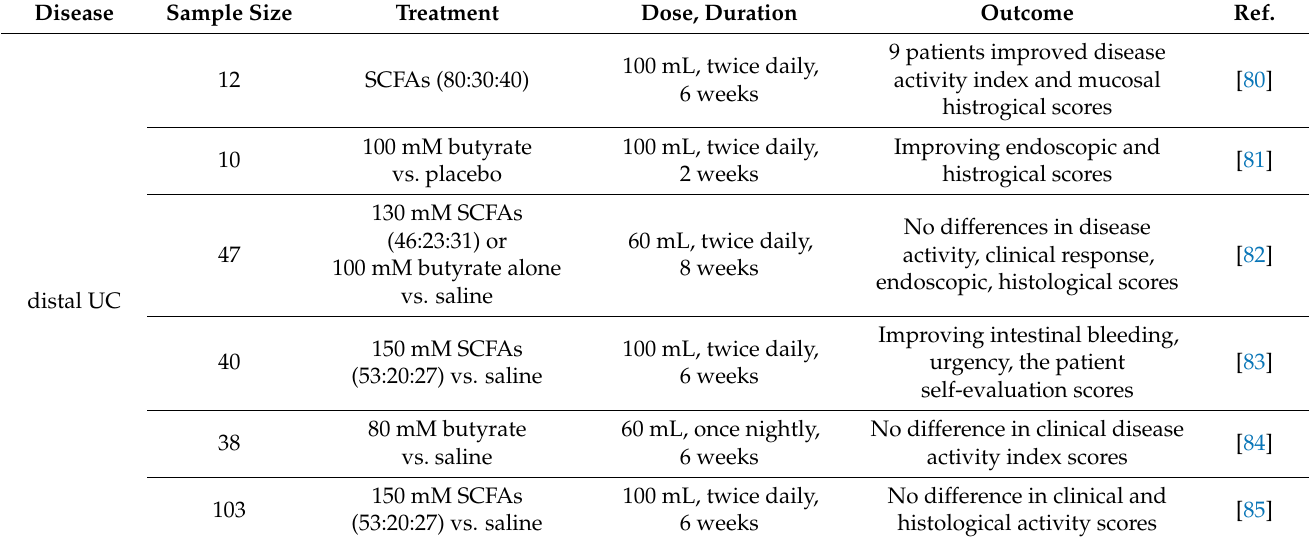
Table 2. Clinical trial results for topical butyrate treatment.